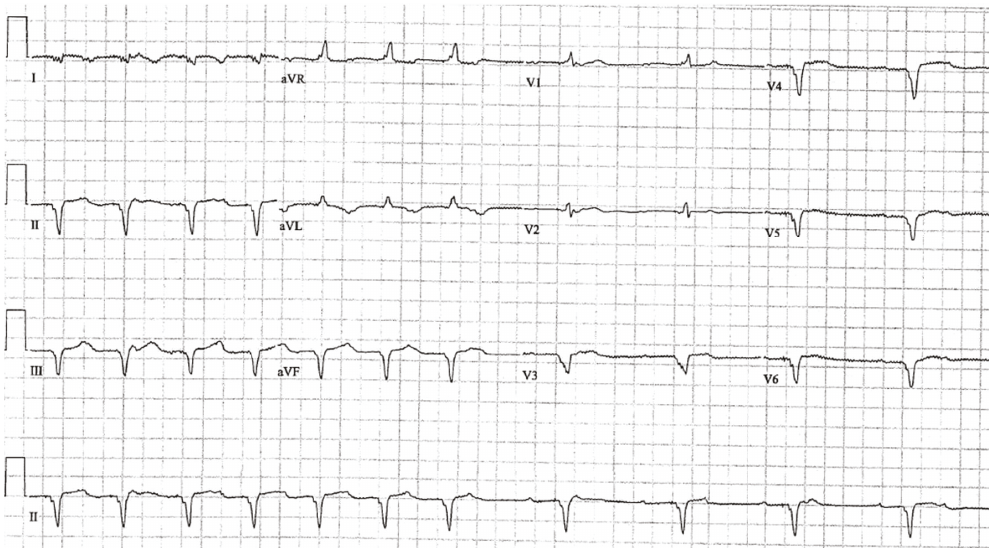
Figure 1: DDD pacing followed by VVI pacing showing an underlying rhythm of complete heart block.